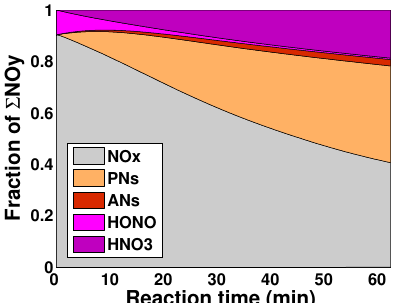
Figure 4. Simulated evolution of total oxidized nitrogen in a nascent biomass burning plume as described in Sect. 3.2. “PNs” represents all peroxy nitrates, and “ANs” represents all alkyl nitrates. The PNs and ANs groups were generated using an algorithm that scans MCM SMILES strings (see Sect. 2.6).